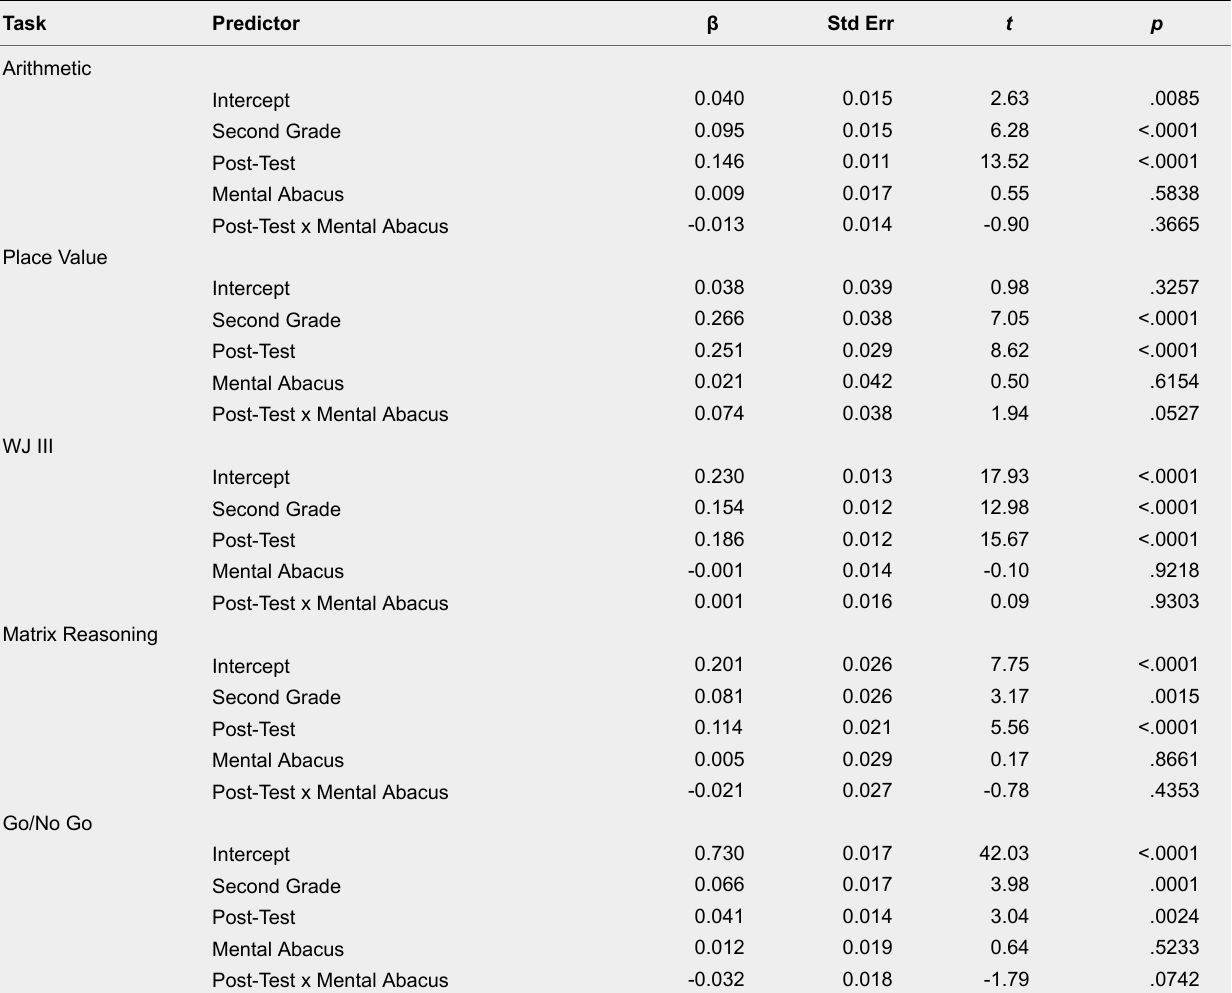
Coefficients and Statistics for Planned Linear Mixed Effects Models Fit to Each